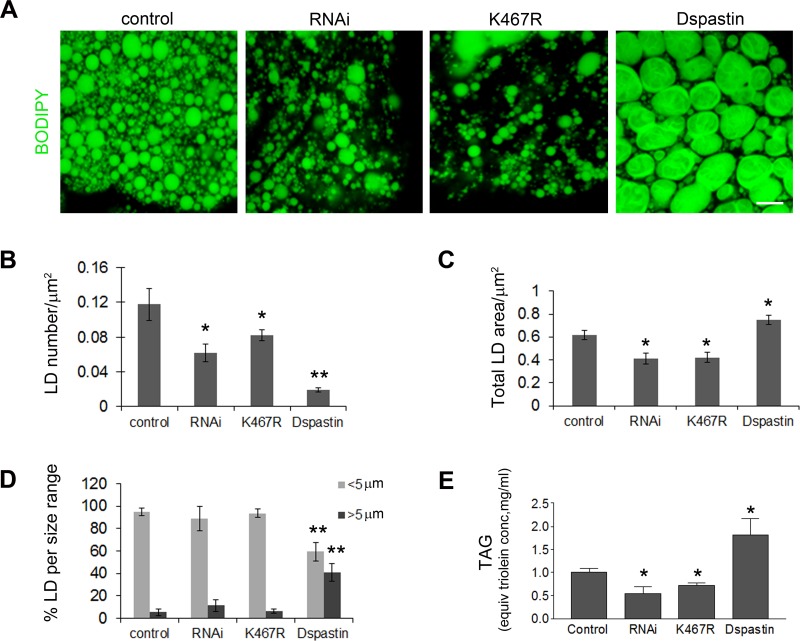
Dspastin dosage affects LD number and size in fat bodies and TAG levels in the larvae.(A) Fat bodies of larvae expressing DspastinRNAi, DspastinK467R and Dspastin using actin-Gal4 were stained with BODIPY 493/503 to visualize LDs. Control genotype (actin-Gal4/+). Downregulation of Dspastin and expression of K467R mutation cause a decrease of LDs and TAG content, whereas overexpression of Dspastin produces fewer and bigger LDs causing an increase of larval TAG content. Scale bar, 50 μm. (B-D) Quantification of LDs number (B), LD total area (C) and LDs size distribution (D) of genotypes shown in A. (E) Biochemical determination of TAG level from third instar larvae. Significance was calculated using unpaired t-test (two-tailed) in B, C and E and Mann-Whitney test in D. Differences were considered statistically significant at p<0.05 (*) and p<0.005 (**).